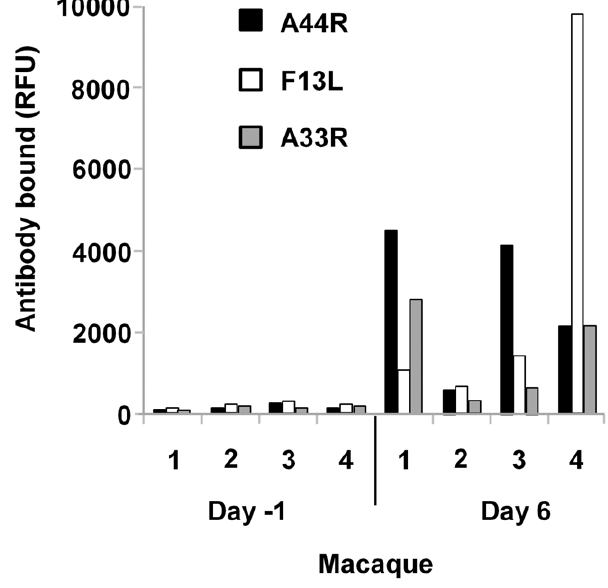
Figure 1. Acute phase IgM binding to ZAIRE proteins. Interactions of arrayed orthopox virus proteins with antibody from serum collected from four macaques (1–4) before ( 2 1) and 6 days after infection with monkeypox virus. Data are presented as mean fluorescent intensity signal (mean RFUs of 2–4 protein spots). SD , 15%.